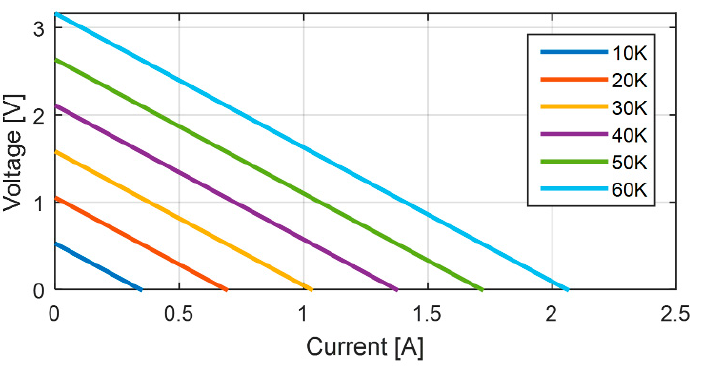
Figure 5. V–I Characteristic Curve.